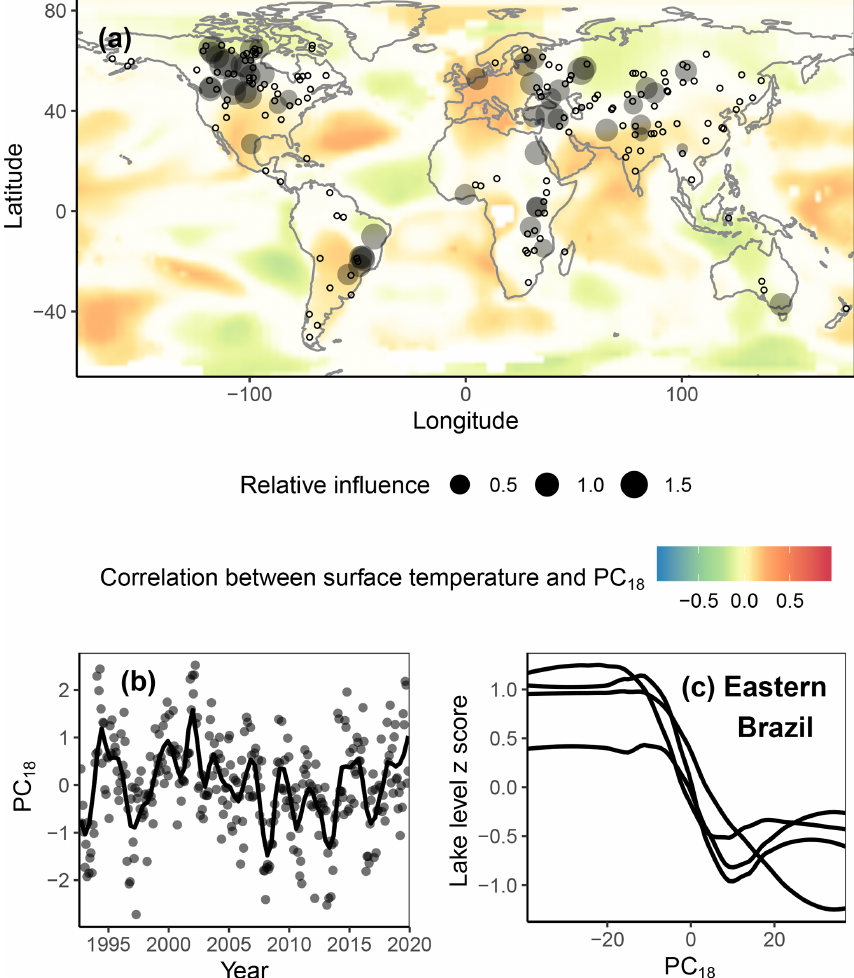
Figure 5. PC 18 is an example of a PC which was important for explaining water levels but was not strongly correlated with any of the climate indices recognized by NOAA. In panel (a) , empty dots represent lakes for which PC 18 was not selected in its “best model”. The opacity of each colored pixel in each map is related to the significance of the correlation between the PC and temperature at that pixel, with less significant correlations appearing white. In panel (b) , the dots represent raw values of PC 18 , and in panels (b) and (c) the lines represent LOWESS-smoothed